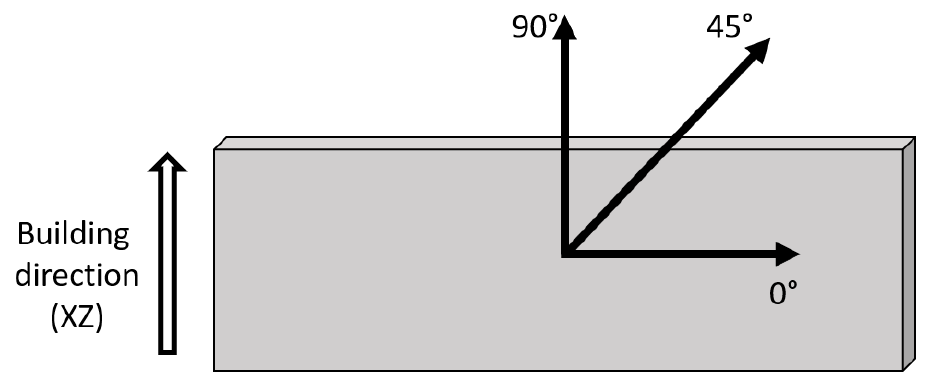
Figure 1. Schematic depicting the reference directions used during residual stress measurements.